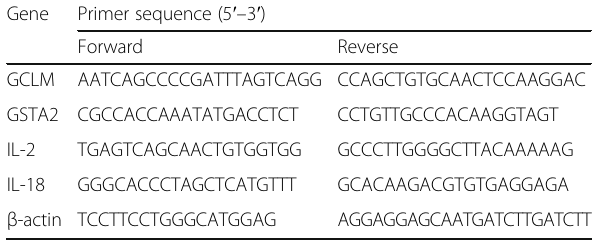
Table 3 Primer sequences for qRT-PCR gene expression